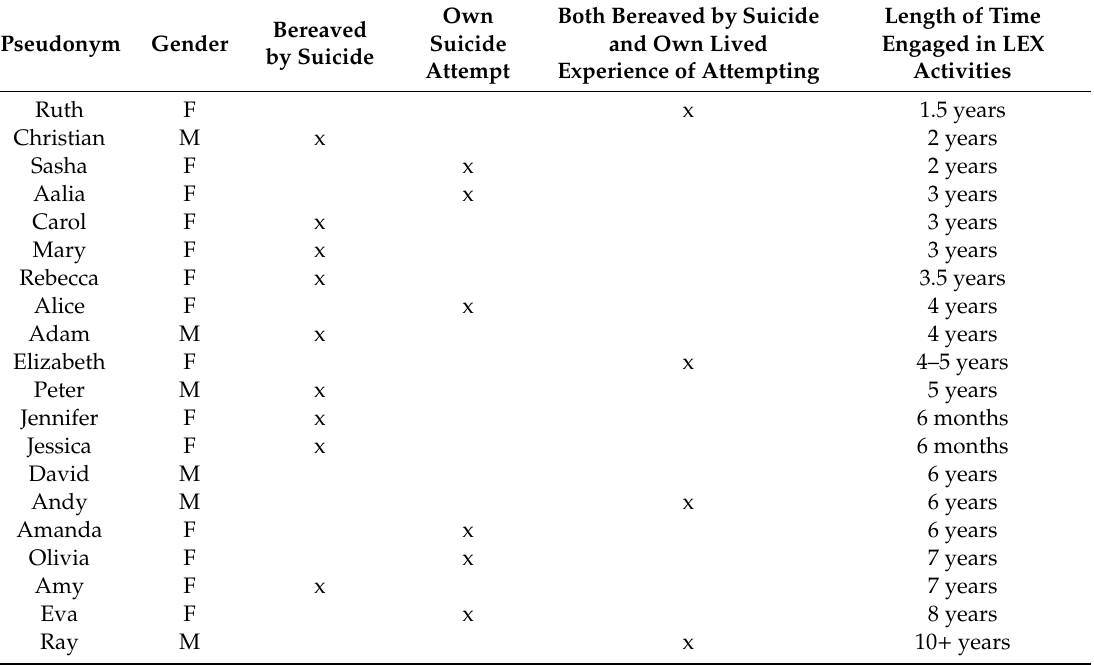
Table 1. Participant information. The participants had experiences of being bereaved by the suicide of a loved one, or via their own attempts. Some had both experiences. Legend = Male (M), Female (F), x = experience defined by participant, LEX = Lived